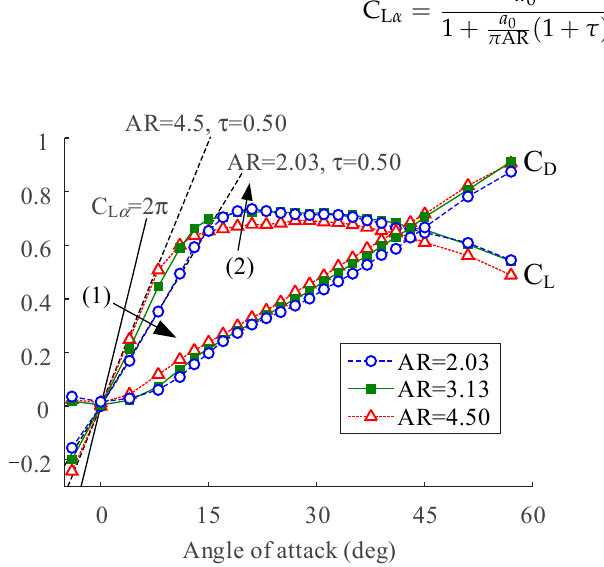
Figure 3. C L - α and C D - α curves for the three AR cases ( β = 0 deg).